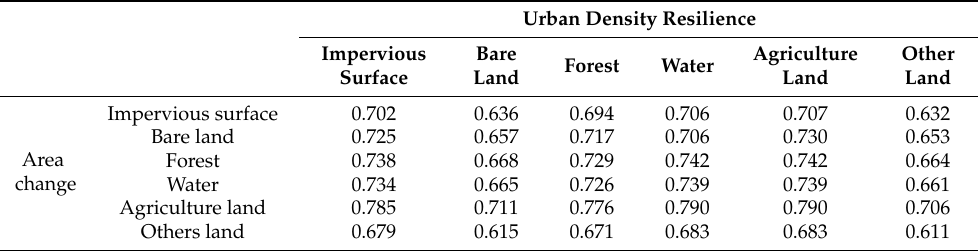
Table 6. The CCD between urban growth and urban density resilience of Mianyang.